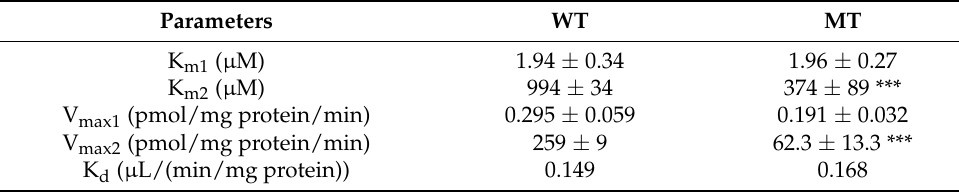
Table 1. Kinetic analysis of [ 3 H] L-carnitine uptake by NSC-34 cell